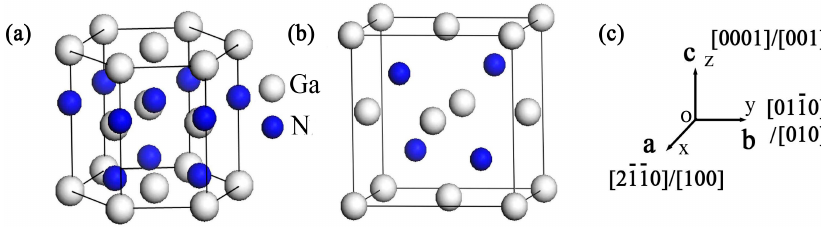
Figure 1. Crystal structures of: Wurtzite GaN ( a ); and zinc-blende GaN ( b ); and the relationship between a , b and c axes and crystallographic directions ( c ).